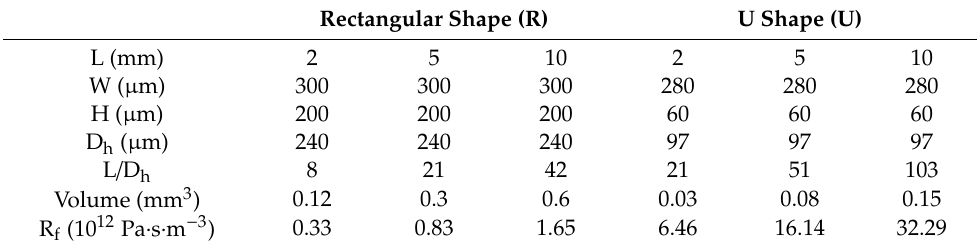
Table 1. Dimensions and geometric features of the microchannels under study. Rectangular Shape